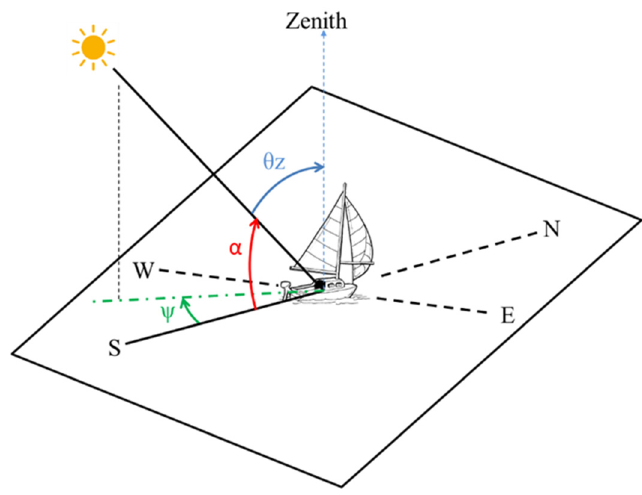
Figure 8. Sun local coordinates: sun height and azimuth angle.